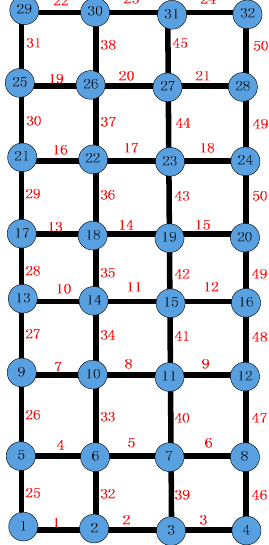
Figure 9. The schematic and actual diagrams of the model made by precise resistors.